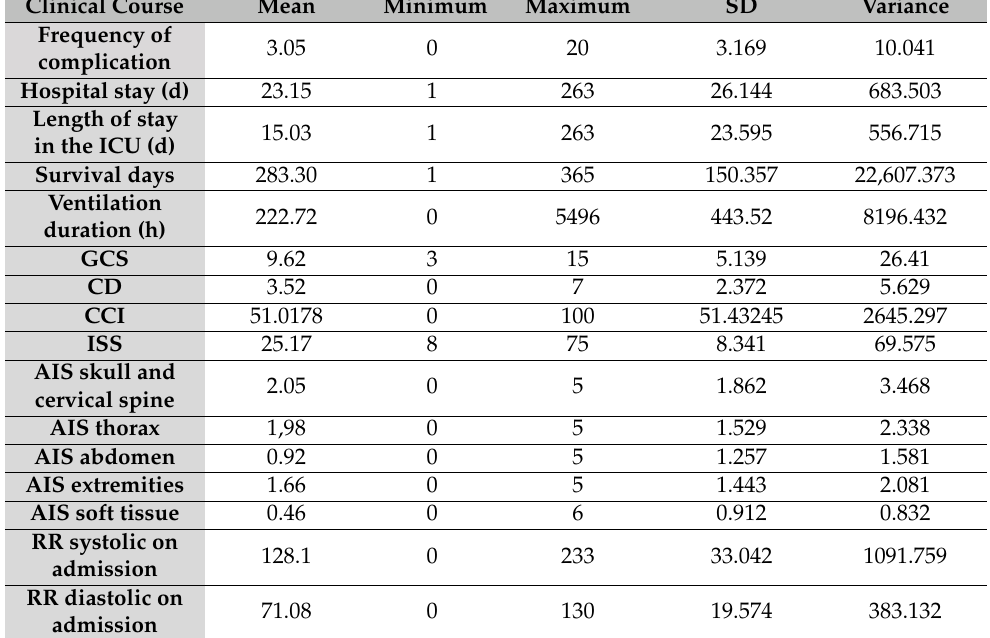
Table 3. Clinical course paramters.